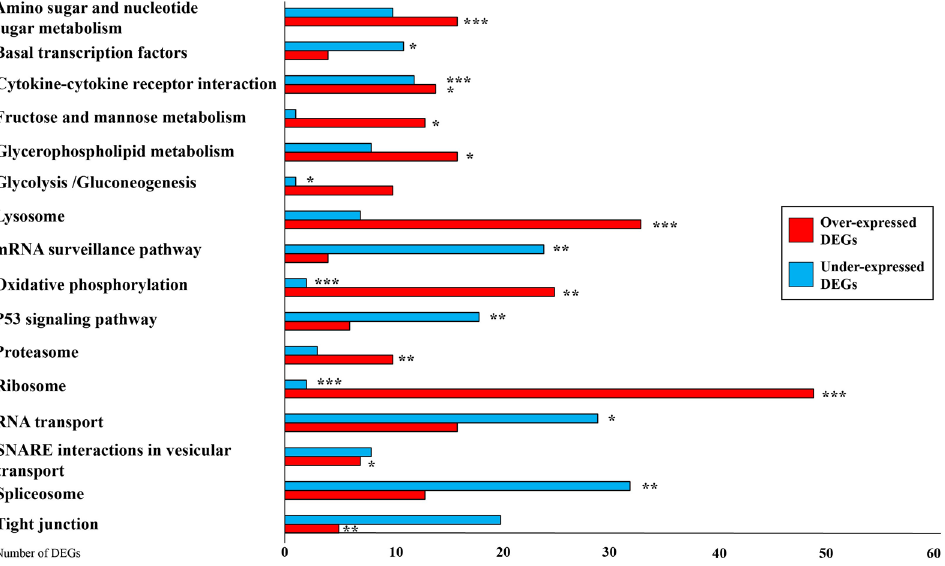
Figure 3. Differentially expressed gene distribution for enriched KEGG. Red bars represent over expressed genes and blue bars stand for under expressed transcripts. * = p ‐ Value ≤ 0.05; ** = p ‐ Value ≤ 0.01; *** = p ‐ Value ≤ 0.001; DEGs = differentially expressed genes.